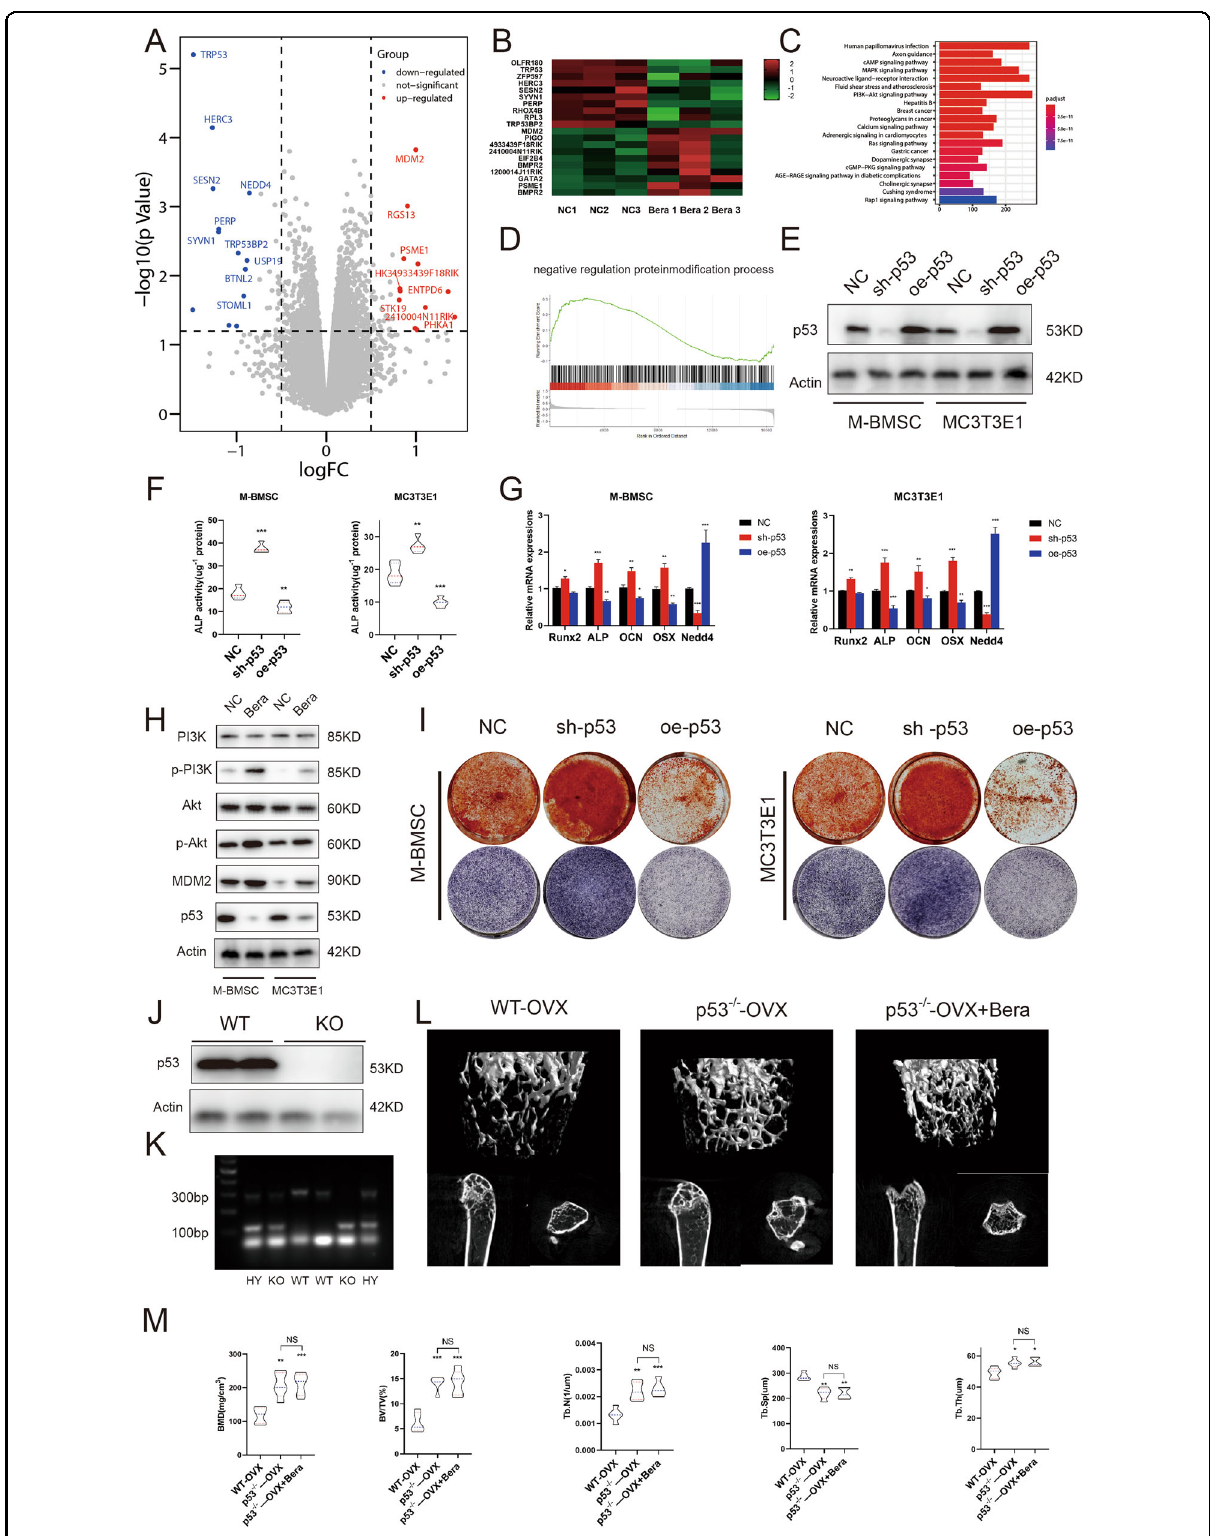
Fig. 5 (See legend on next